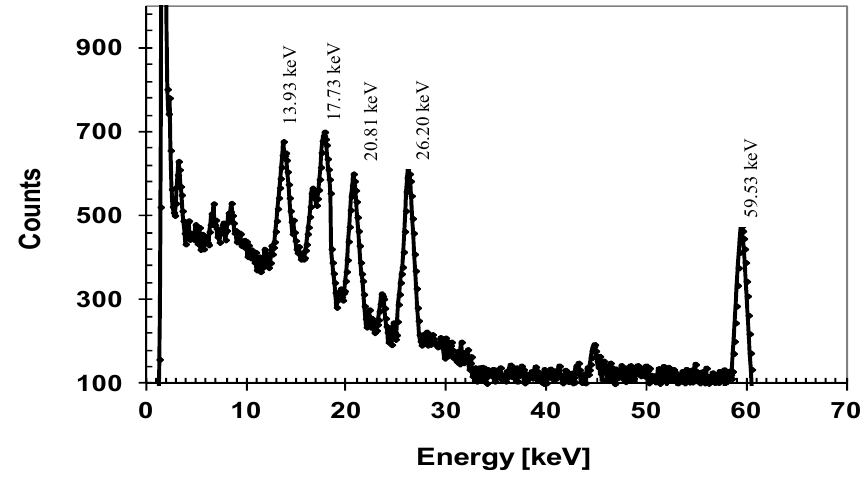
Figure 12. 241 Am spectrum of a 4H-SiC detector (8.0 mm 2 ) at 300 K, 250 V bias, and 4 μ s shaping time.